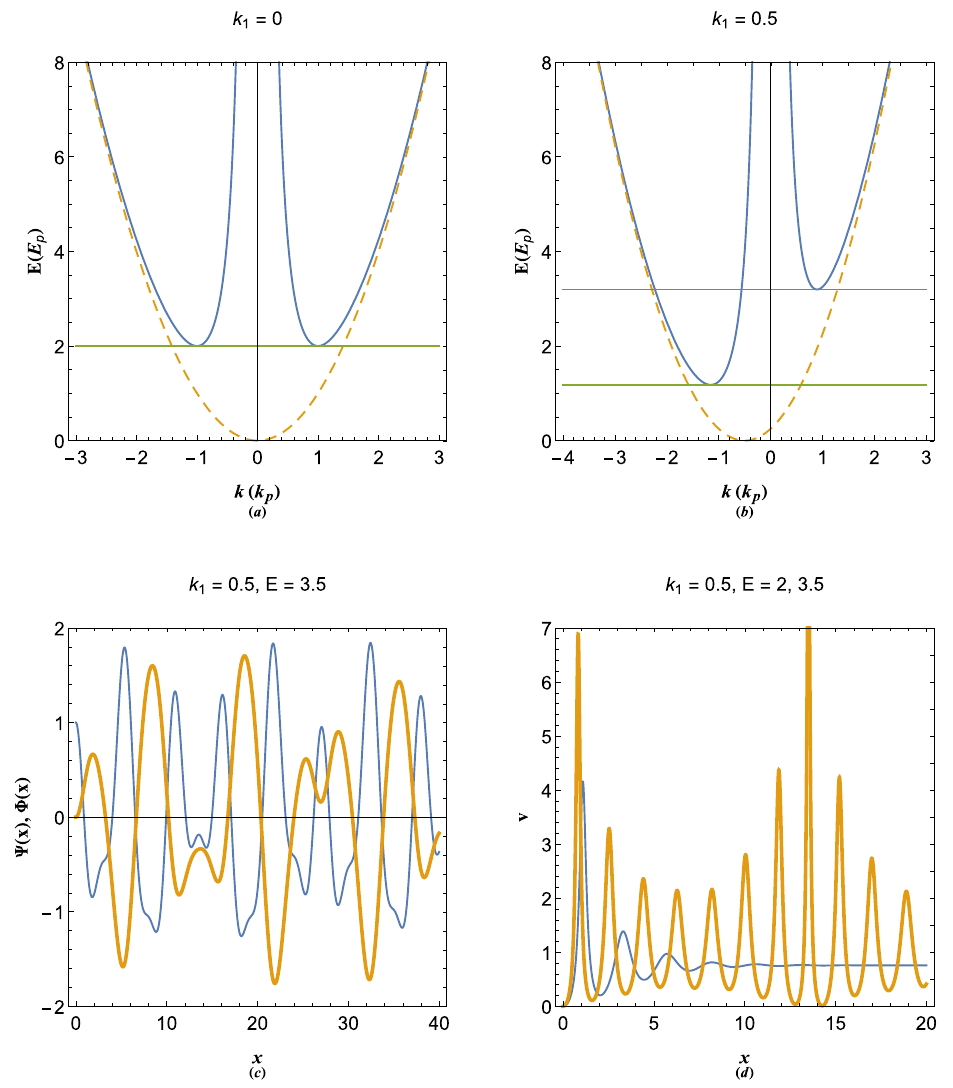
Figure 2. Dispersion curves of ( a ) static and ( b ) streaming free electron (dashed curve) and plasmon (solid curve) excitations. ( c ) Variation of state-functions �( x ) (thin curve) and φ( x ) (thick curve) in streaming electron gas with the de Broglie wavenumber k 1 corresponding to the one-stream electron gas in ( c ) at stable E curve)